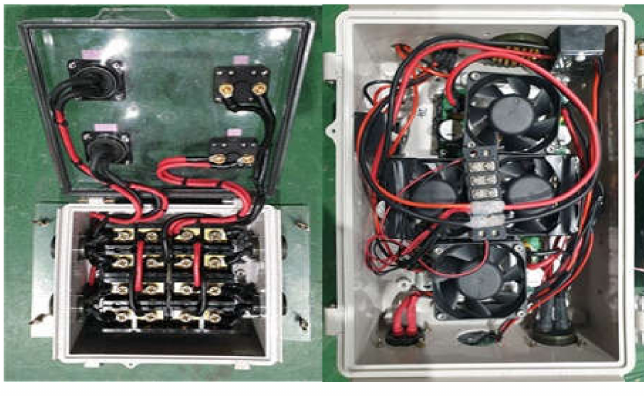
Figure 10. Power system control modules of USV.